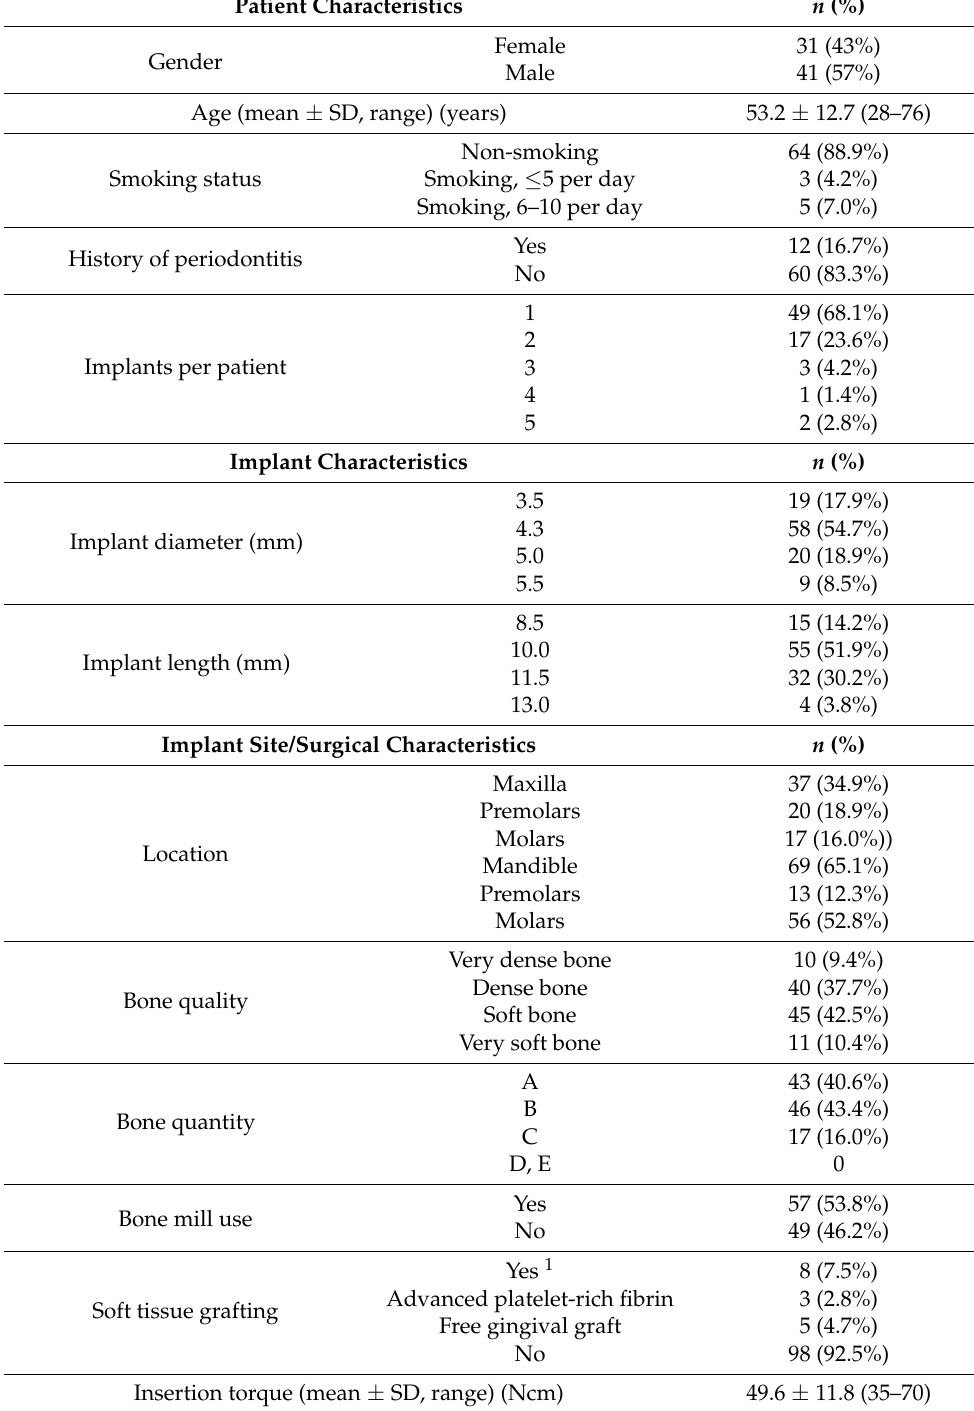
Table 1. Baseline characteristics at